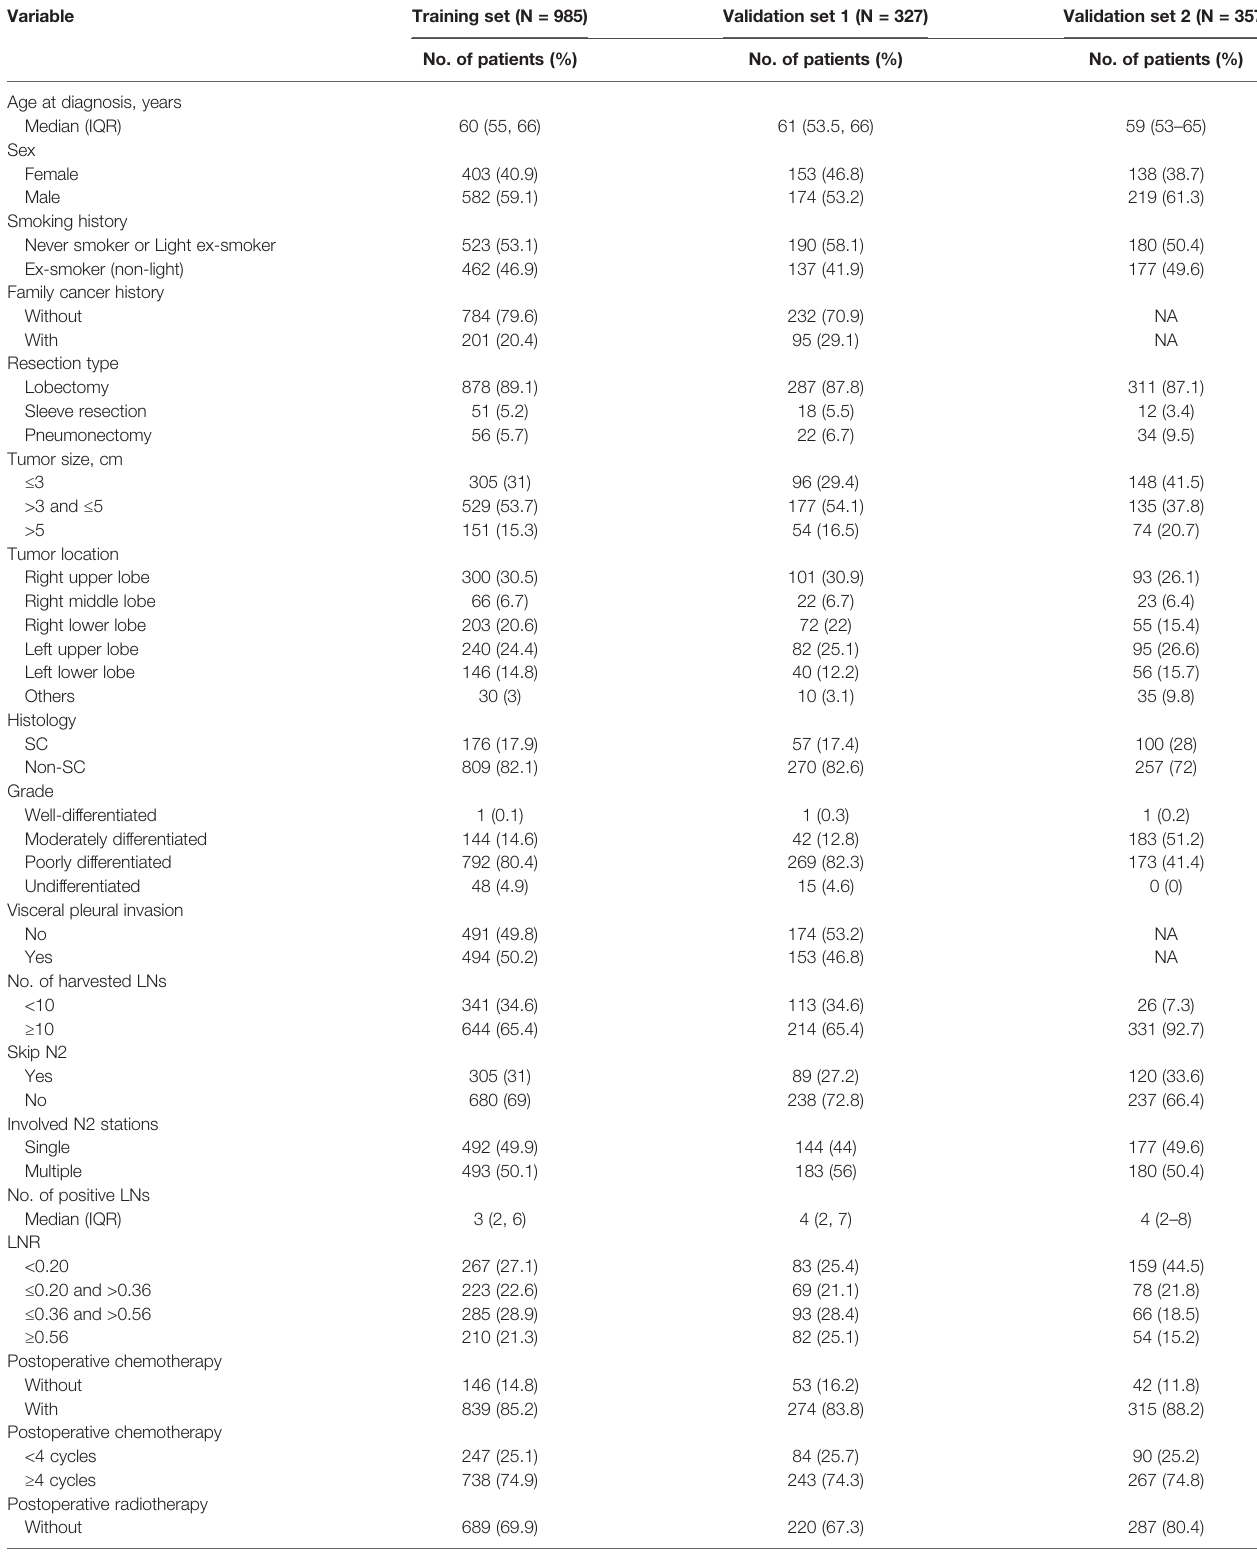
TABLE 1 | Baseline demographics and clinical characteristics of training set and validation